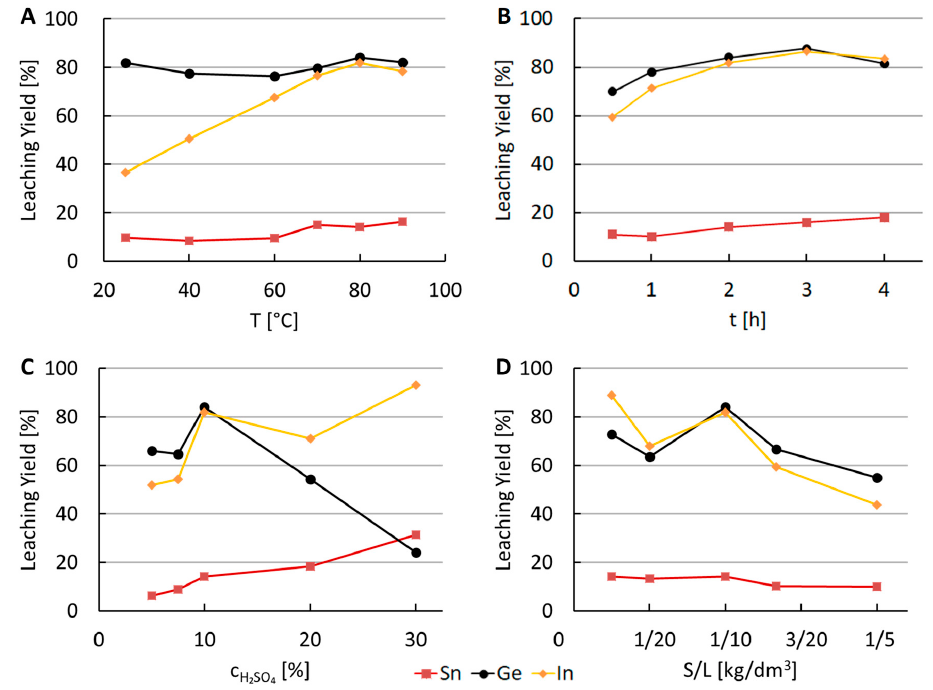
Figure 2. Leachabilities of tin, germanium and indium in sulphuric acid solution. Influence of: ( A )